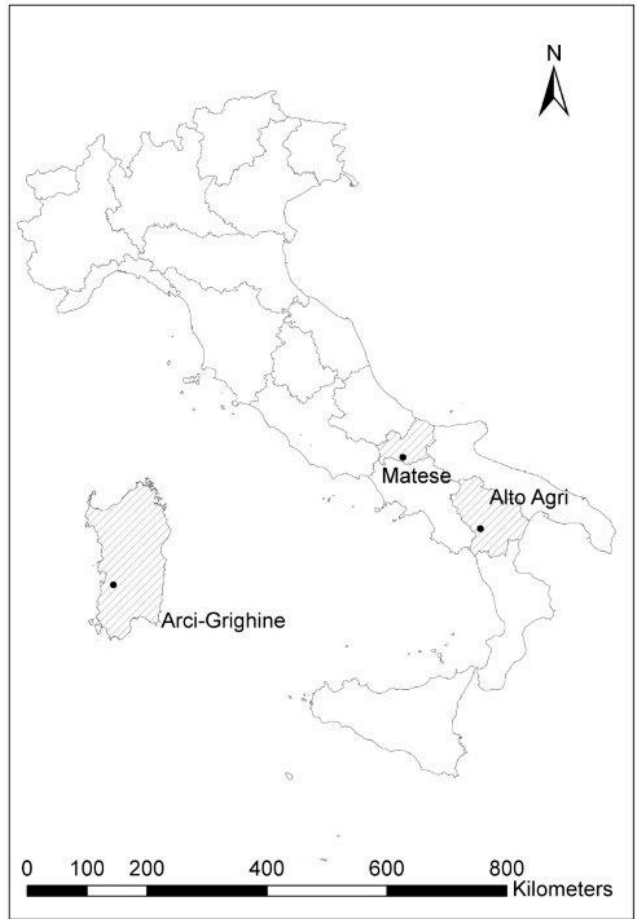
Figure 1. Location of study areas in Italy.